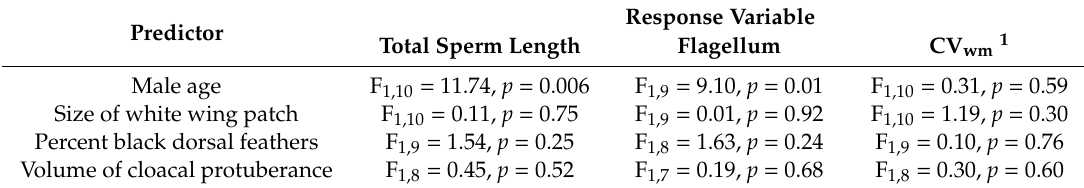
Table 2. Statistical results of the relationship between sperm and ejaculate measurements compared to male traits possibly linked to extra-pair paternity. Uncorrected p -values are shown; after correction, no tests had p <